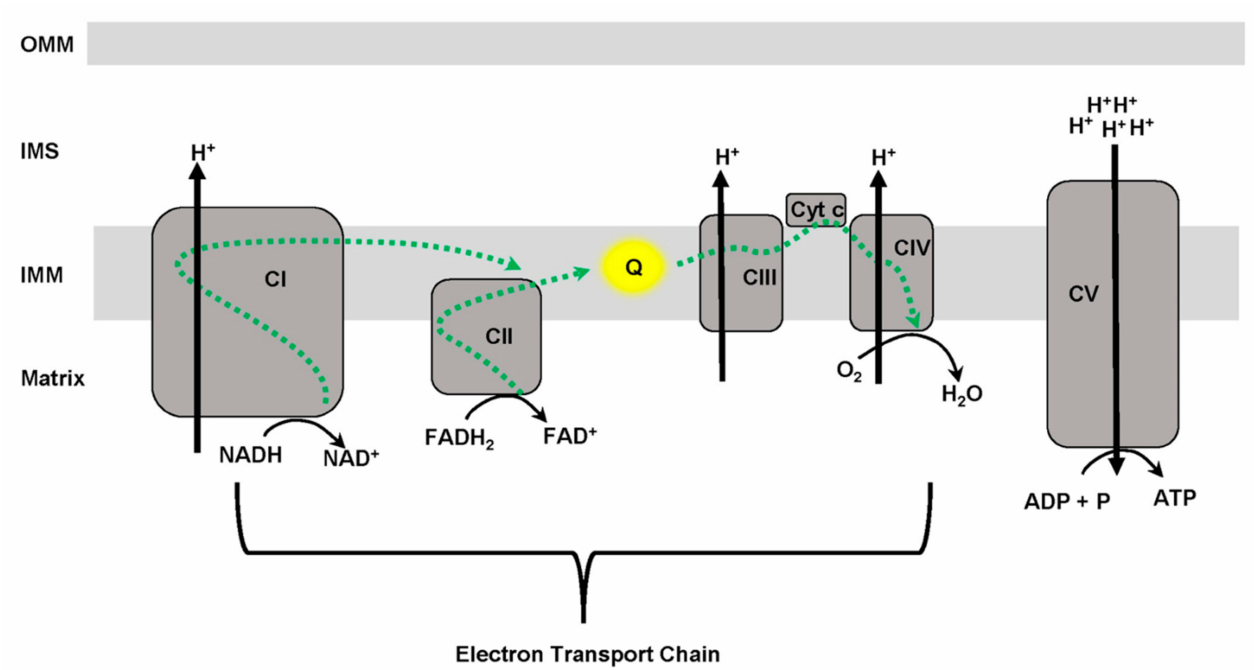
Figure 1. Mitochondrial oxidative phosphorylation (OXPHOS). A mitochondrion is comprised of an outer mitochondrial membrane (OMM), intermembrane space (IMS), inner mitochondrial membrane (IMM) and matrix. Electrons from NADH and FADH 2 enter the electron transport chain (ETC) at complex I (CI) and complex II (CII), respectively, and are passed to ubiquinone (Q), which then transfers electrons to complex III (CIII). Cytochrome c (Cyt C) transfers electrons from CIII to complex IV (CIV) where O 2 as the final electron acceptor is reduced to H 2 O. The movement of electrons along the electron transport chain (ETC) results in protons (H + ) being pump out from the matrix to the IMS at CI, CIII, and CIV. Ultimately, protons are channeled back into the matrix through complex V (CV) where ADP and P are coupled to form